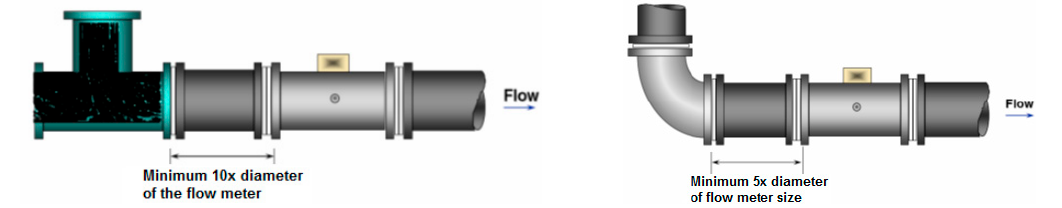
Figure 5. Installation requirements for different pipe layouts.